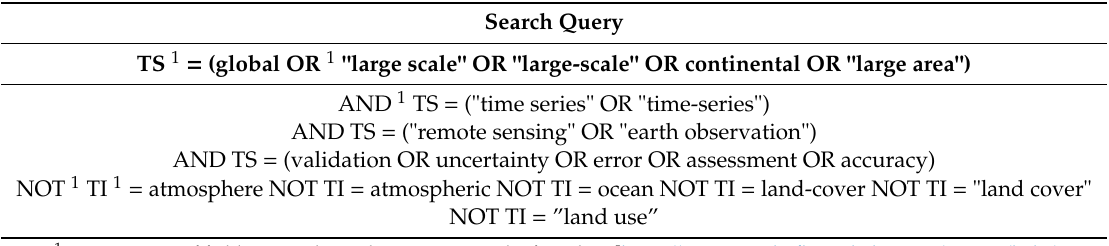
Table A2. Keywords for the literature search in the Web of Science database. Search